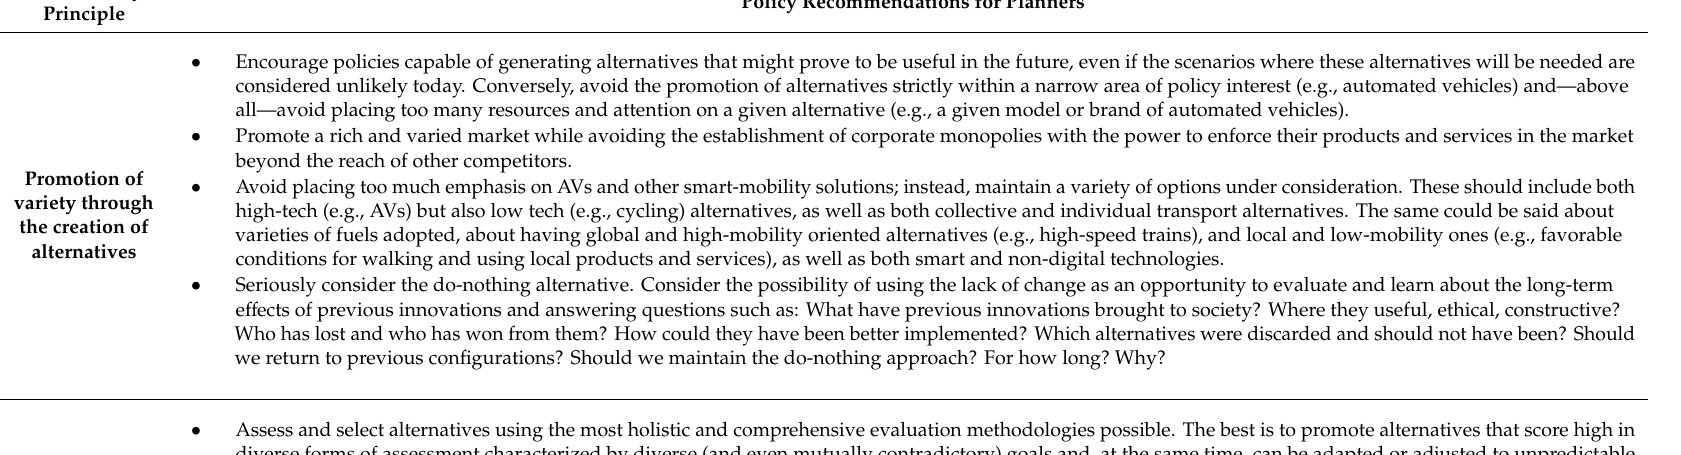
Table 1. List of policy recommendations for planners concerned with innovation policy in general and automated vehicles (AVs) in particular. Evolutionary